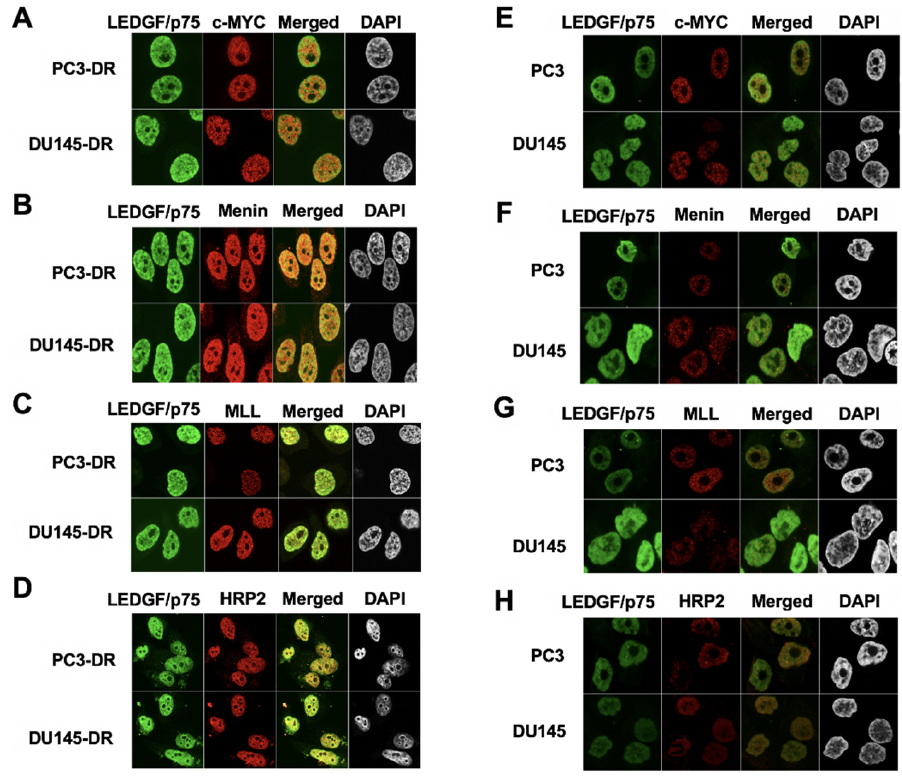
Figure 5. LEDGF/p75 co-localizes with selected IBD-interacting partners in DTX-resistant PCa cells. Rabbit antibodies to c-MYC ( A , E ), menin ( B , F ), MLL ( C , G ), and HRP2 ( D , H ) were co-incubated with human anti-LEDGF/p75 auto-antibodies in DTX-resistant and DTX-sensitive cells, and detected with rhodamine-labeled secondary antibody (red). Merged images show the yellow-orange staining typical of co-localization. DAPI was used for nuclear staining. Images were acquired by confocal microscopy.